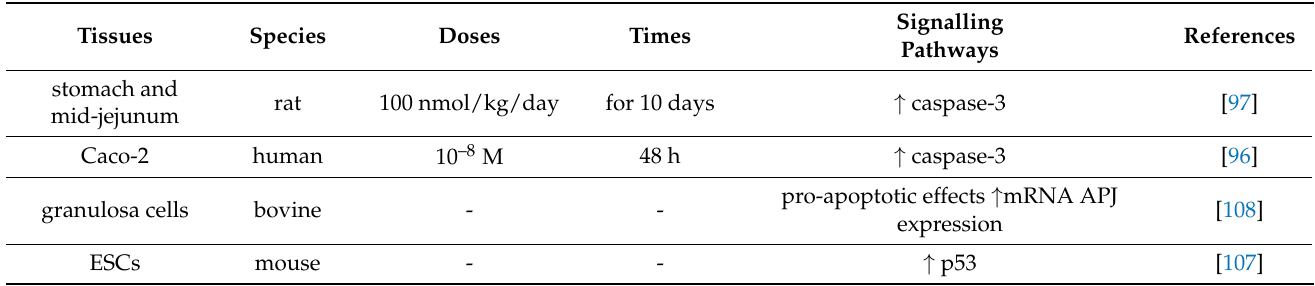
Table 2. Pro-apoptotic effects of apelinergic system. Stimulation, ↑